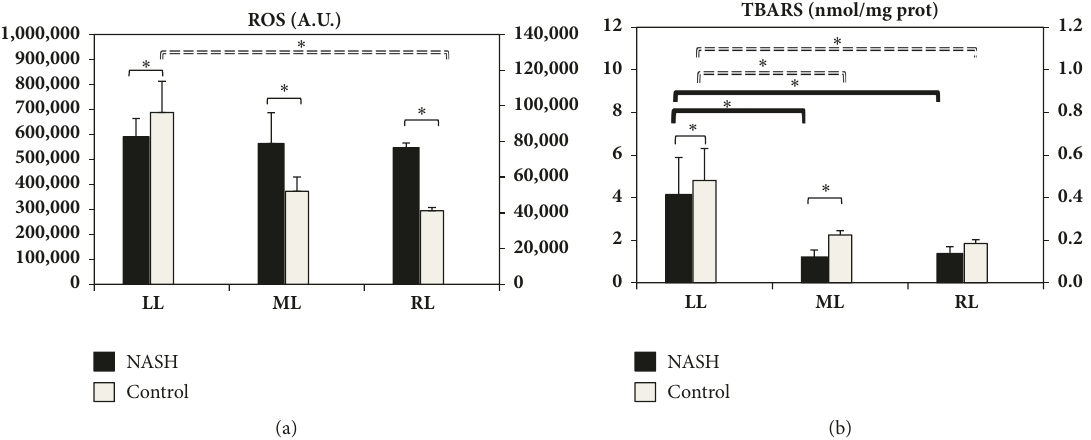
Figure 6: Hepatic levels of ROS (a) and TBARS (b) obtained from LL, ML, and RL in NASH and control rats. Data are shown as mean values ± SE. ∗ p < 0.05.